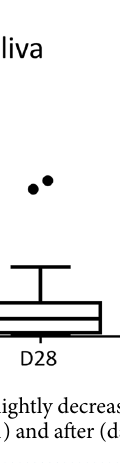
lesion size reduction alone may be a difficult parameter to assess since OLP lesions have irregular forms, and variable clinical phenotypes, i.e. atrophic or/and erosive areas within the same lesion. Major efforts have been made to develop and validate clinical markers for mucosal lesions in OLP including individual scoring systems 53 and measurement of lesions with calipers or periodontal probes 46 and /or scored the lesions using the Thongprasom score 5,13,45–47,49 . To address this issue, we sought to standardize the measurement of OLP lesions by a computer software using clinical photographs on one hand, and by measuring the lesions in two directions (horizontally and vertically) related to fixed intraoral reference points on the other hand. In con- trast to previous studies, only one oral lesion per patient was treated to give a single value per lesion size per time point 45,46,53 . This may have been a drawback of the study, when considering the parameter QOL. The effect of PDT on the oral microbiome has been only minimally investigated. Reports based on studies in mice 54,55 and humans 56,57 have shown that photobiomodulation (therapeutical application of low levels of red and/or near-infrarated light) may positively affect the human microbiome 54 . Additionally, studies investigating the effect of antibacterial PDT on oral bacteria have shown that various photosensitizers may exercise various